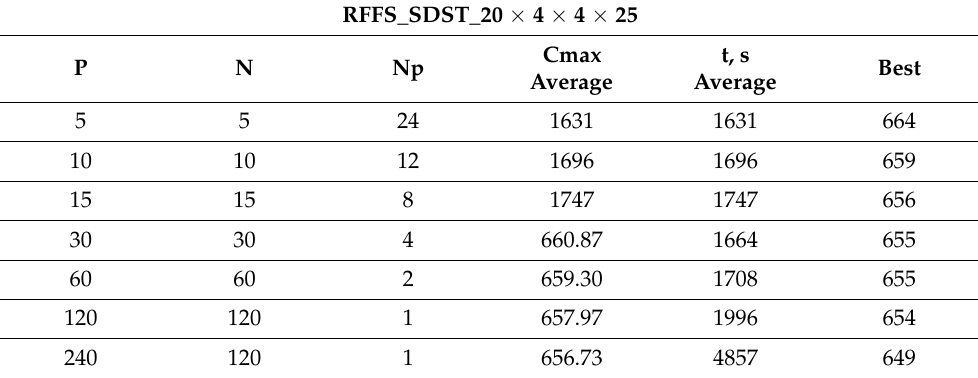
Table 8. RFFS_SDST_40 × 4 × 4 × 25 results.